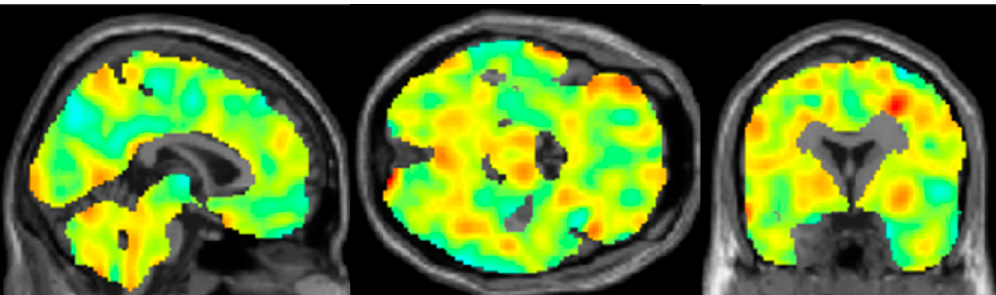
Figure 1. Visualization of the reconstructed hyperplane maximally separating AD patients from healthy controls using the SVM-ISDA algorithm, developed from our previous work [30]. Warmer colors (red, orange) indicate regions of hypermetabolism, while cooler colors (blue, green) indicate regions of hypometabolism. PET scans with a high degree of concordance in metabolism with this hyperplane are designated as MAD+ and highly discordant scans are designated as